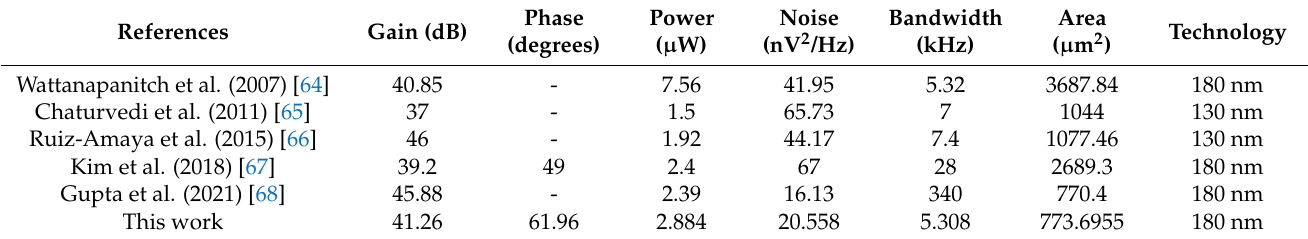
Table 5. Comparison with other relevant